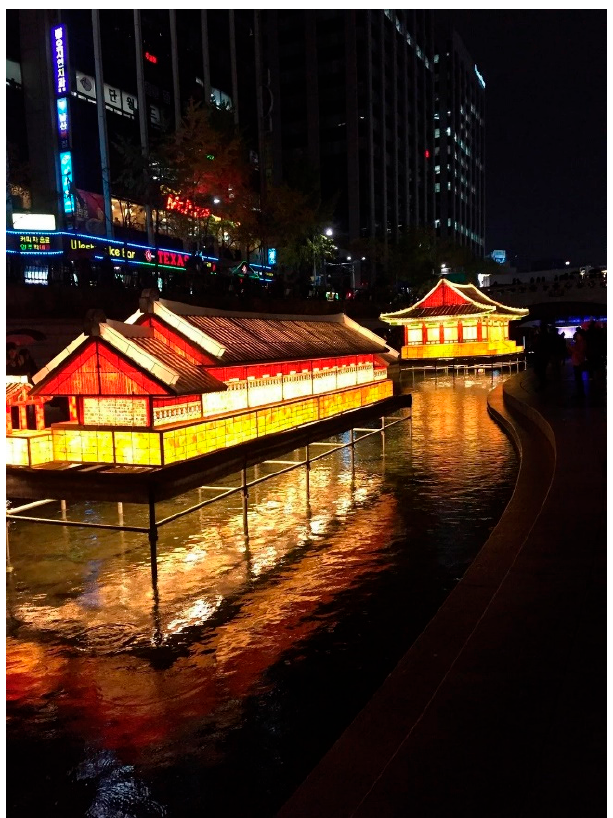
Figure 10. Lantern installations showing traditional shrine and palace architecture.